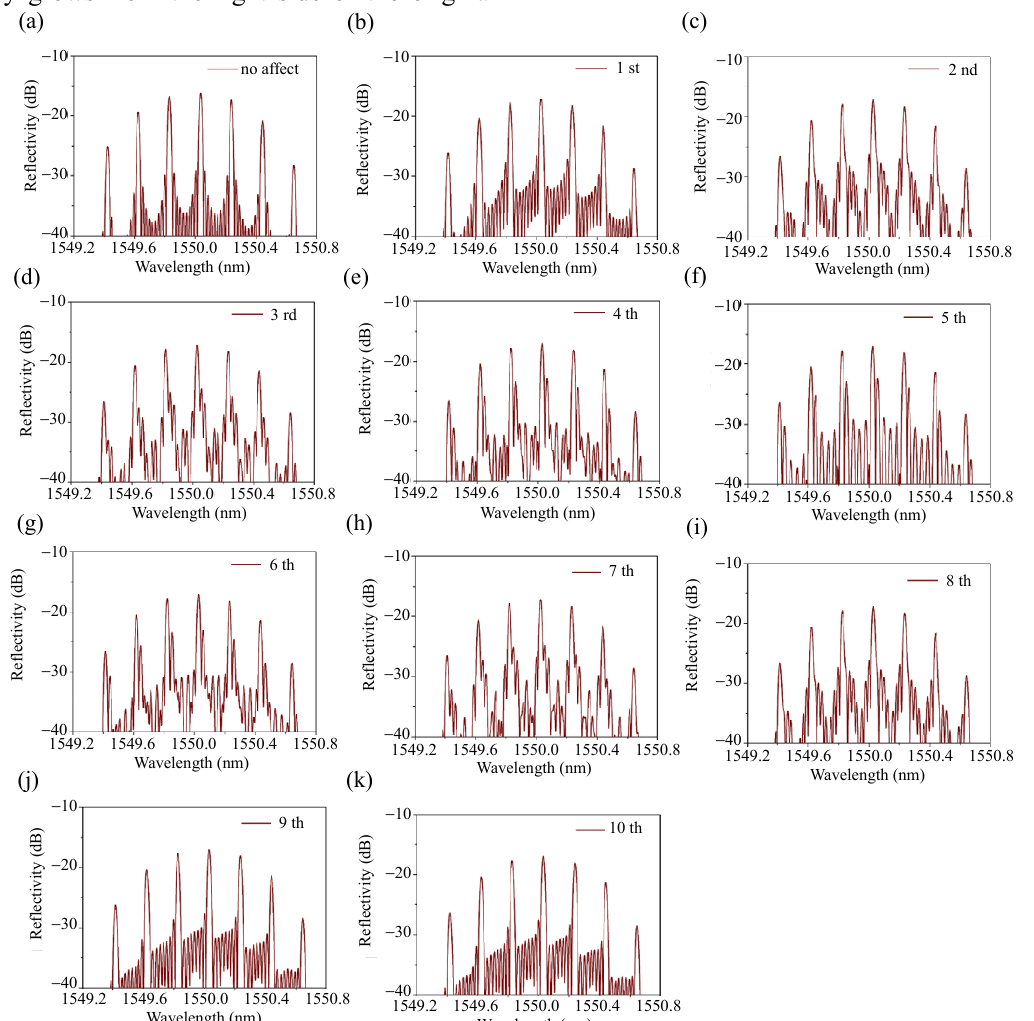
Fig. 6 Reflection spectra of the SFG with different regions of the sub-grating: (a) no affect and (b)–(k) Regions